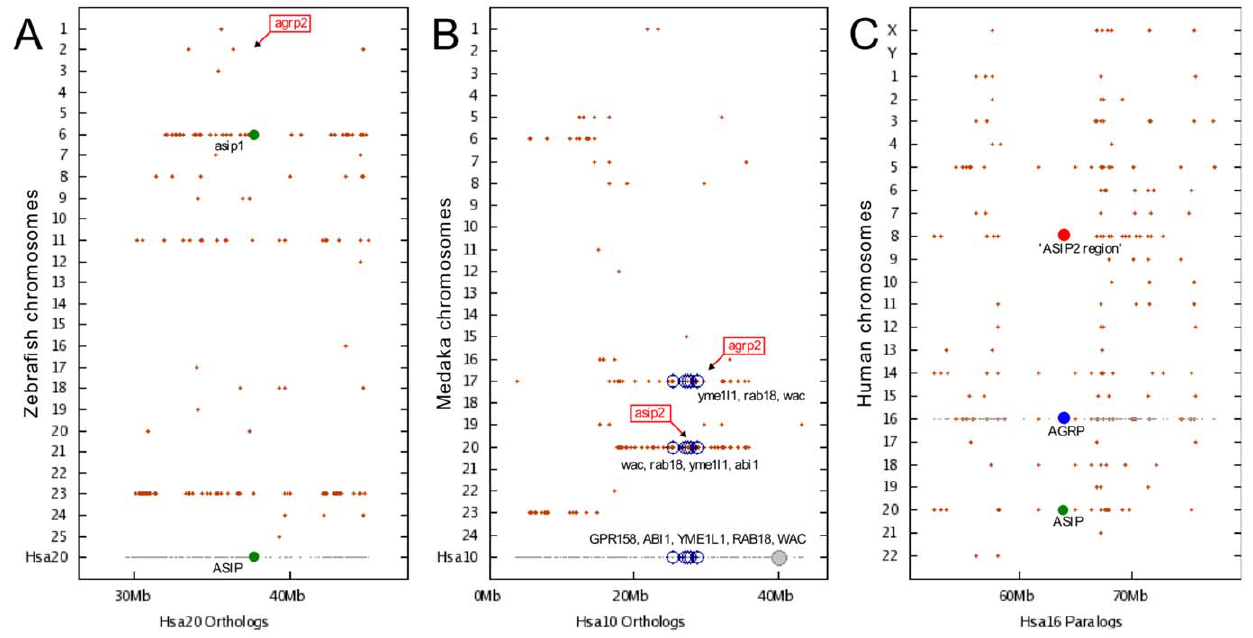
Figure 5. Conserved synteny dot plots derived from the Synteny Database [ 17 ] . (A–C) Conserved synteny dot plots derived from the Synteny Database [17]. (A) The zebrafish AgRP2 region on Dre 2 (red box) shares conserved syntenies with neither the zebrafish ASIP1 region (Dre 6) nor with the human ASIP region (Hsa 20). (B) The AgRP2 and ASIP2 regions in medaka and other teleosts share conserved synteny with each other and with a region on human Hsa10, including several AgRP2 - and ASIP2 -neighboring genes. (C) Analysis of the human genome shows that the AgRP region on Hsa16 shows more paralogous connections to the inferred ASIP2 region on Hsa 8 than to the ASIP region on Hsa 20 (183 vs. 82 genes, respectively, not restricting Y-axis chromosomal regions).